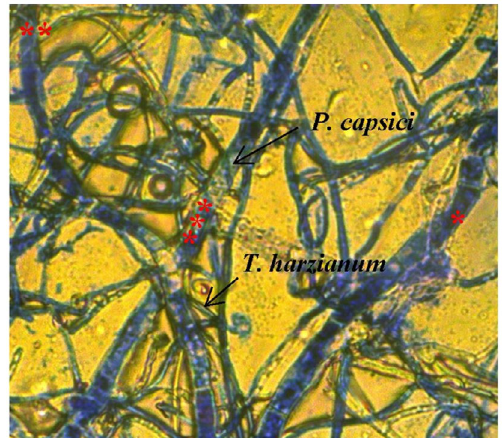
Fig. 1. Mycoparasitism of T. harzianum on the hyphae of P. capsici , *hypha swelling, **hypha curl, ***granulations within hypha